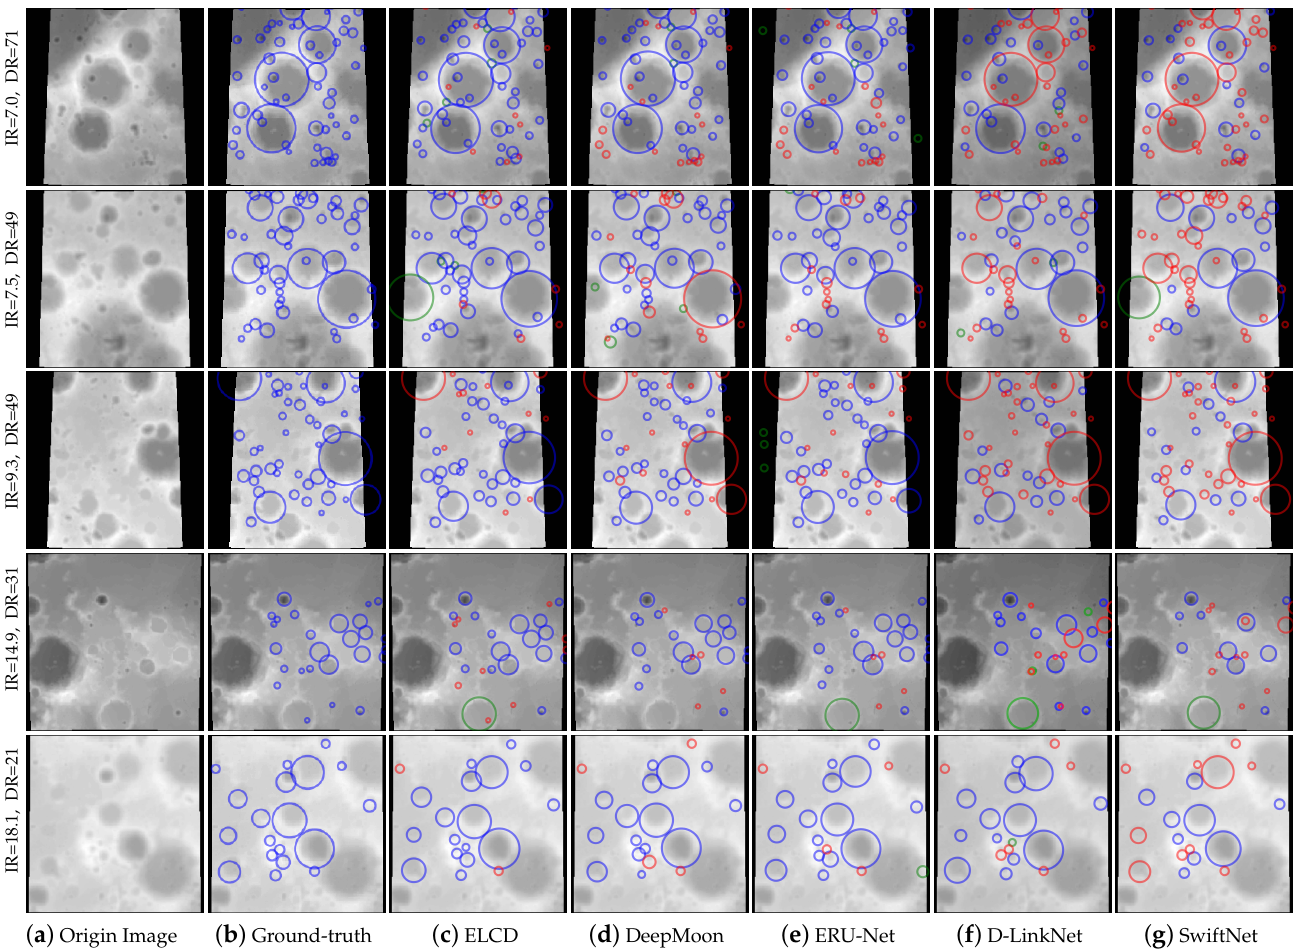
Figure 12. Comparison of the results of test sets using different crater detection methods for DEM data. ( a ) The original lunar DEM images in the test set. ( b ) The ground-truth DEM image. ( c ) The detection results obtained with DeepMoon based on U-net [35]. ( d ) The recognition results obtained with the ERU-Net network [36]. ( e ) The detection results obtained with D-LinkNet with the ResNet-18 network [23]. ( f ) The detection results obtained with SwiftNet ( g ), designed by the paper [24]. In the figure, the blue circles represent correctly recognized crates, the green circles denote new craters discovered by compared methods, and the red circle indicates unrecognized